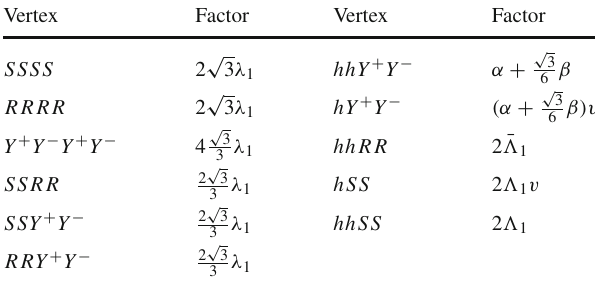
Table 1 The vertex factors for the IDM